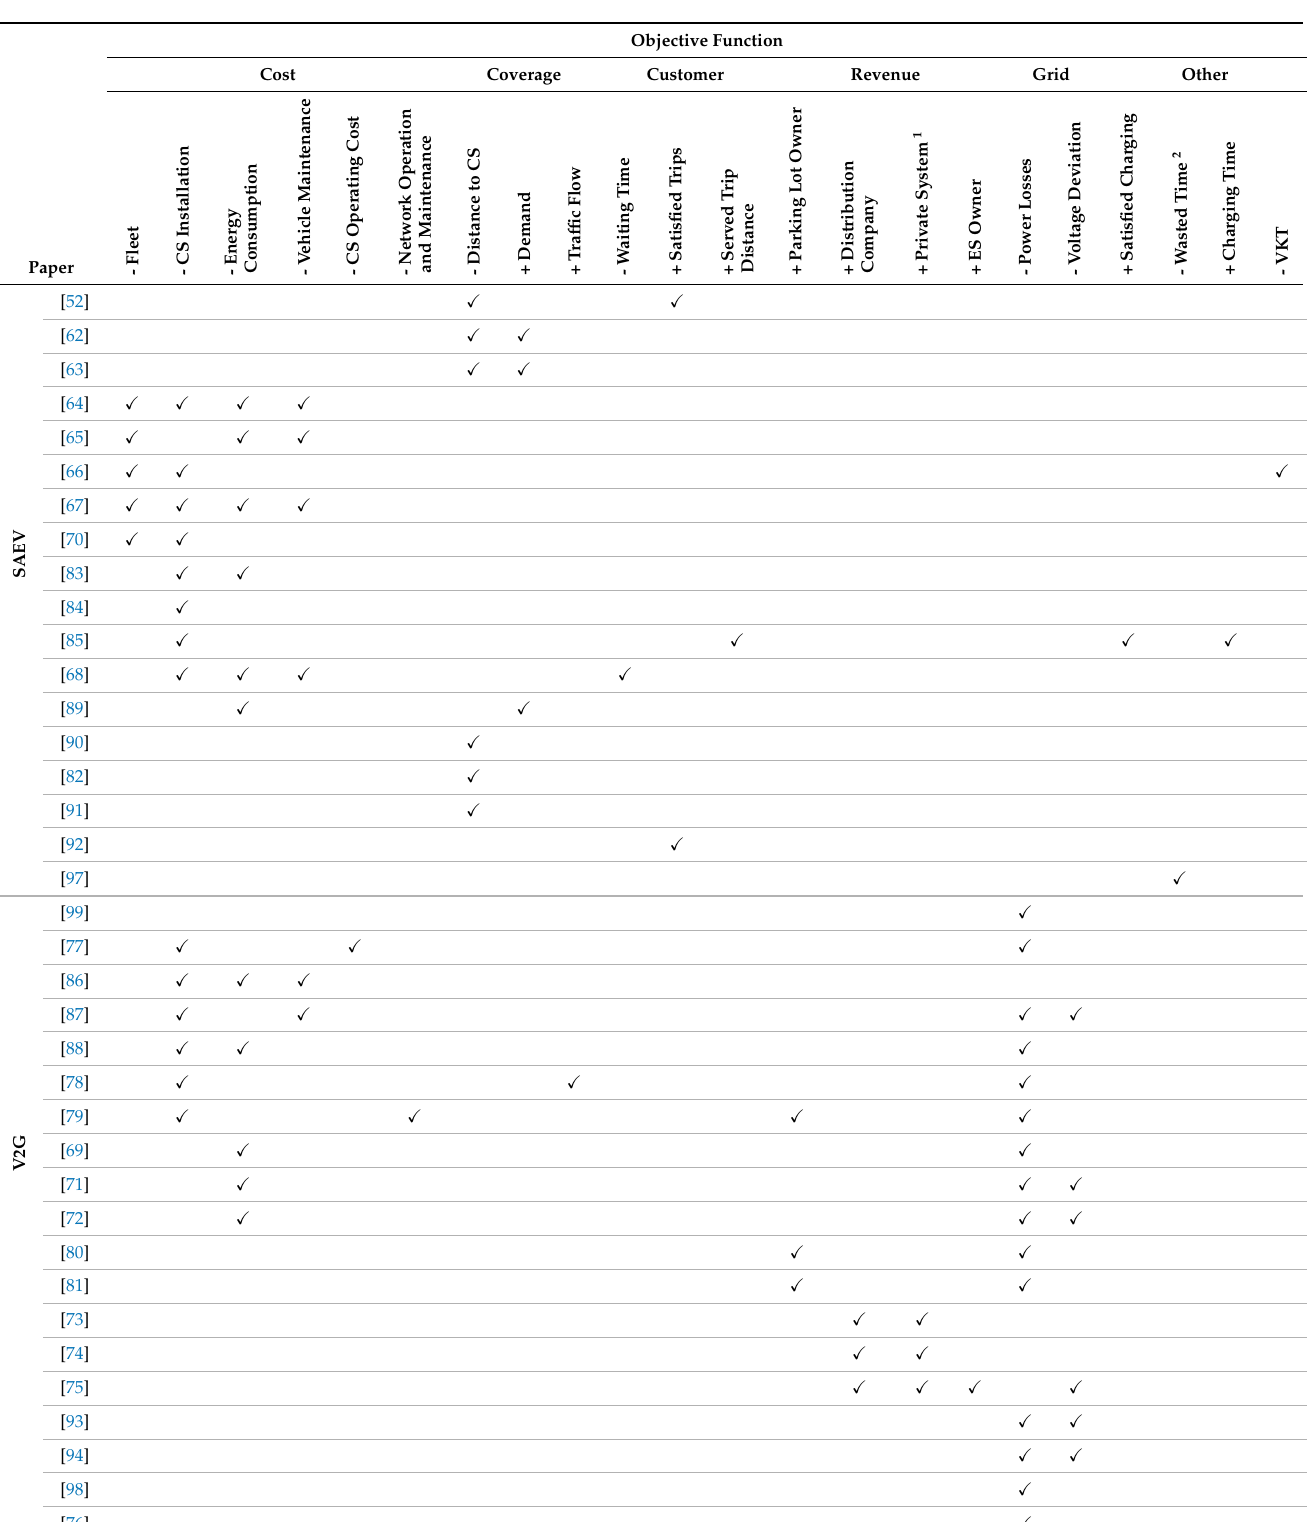
Table A2. The different objective functions considered by SAEV and V2G papers. + = maximize; - =